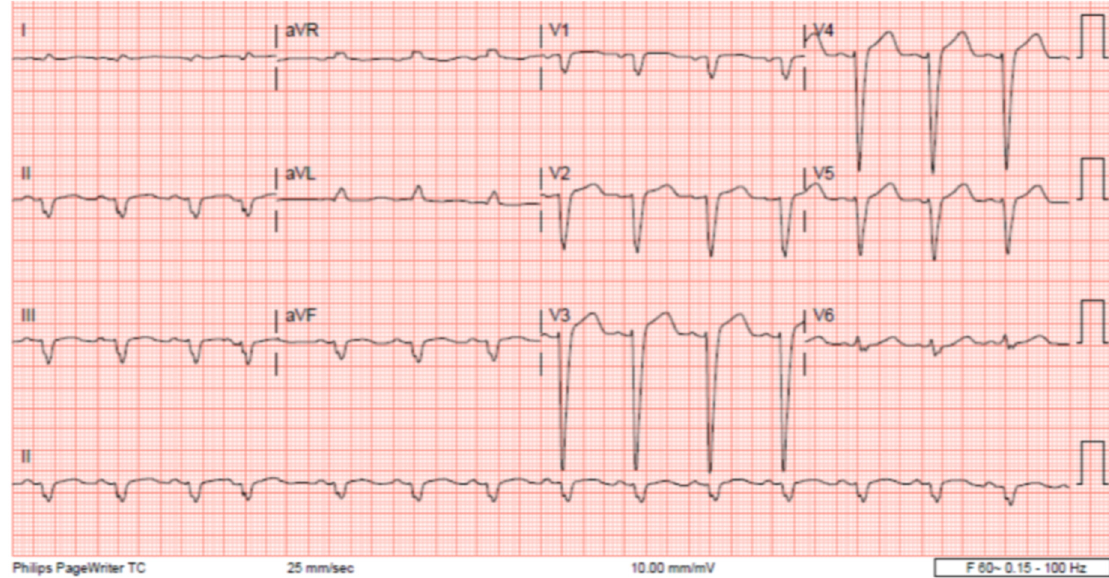
Figure 1. The patient’s EKG on admission, demonstrating left ventricular hypertrophy not previously documented in the patient’s medical history.